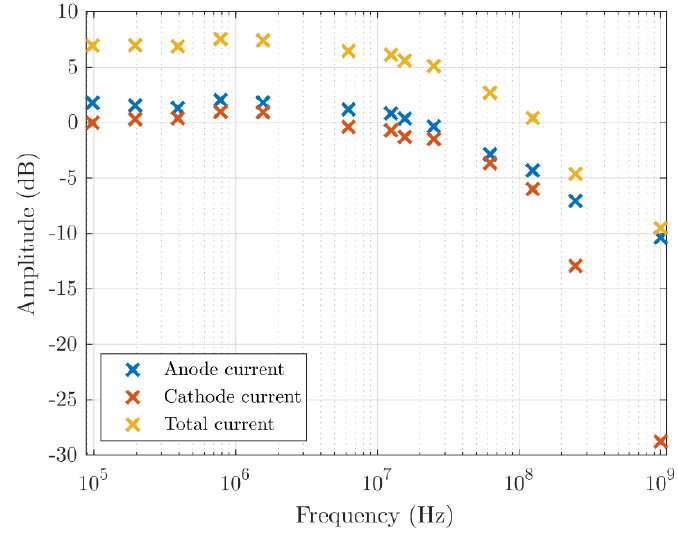
Figure 9. The normalized frequency response of the anode and cathode current at an average optical power of 360 µW, V anode = V cathode = 0 V, V ring = V substrate = −5 V.